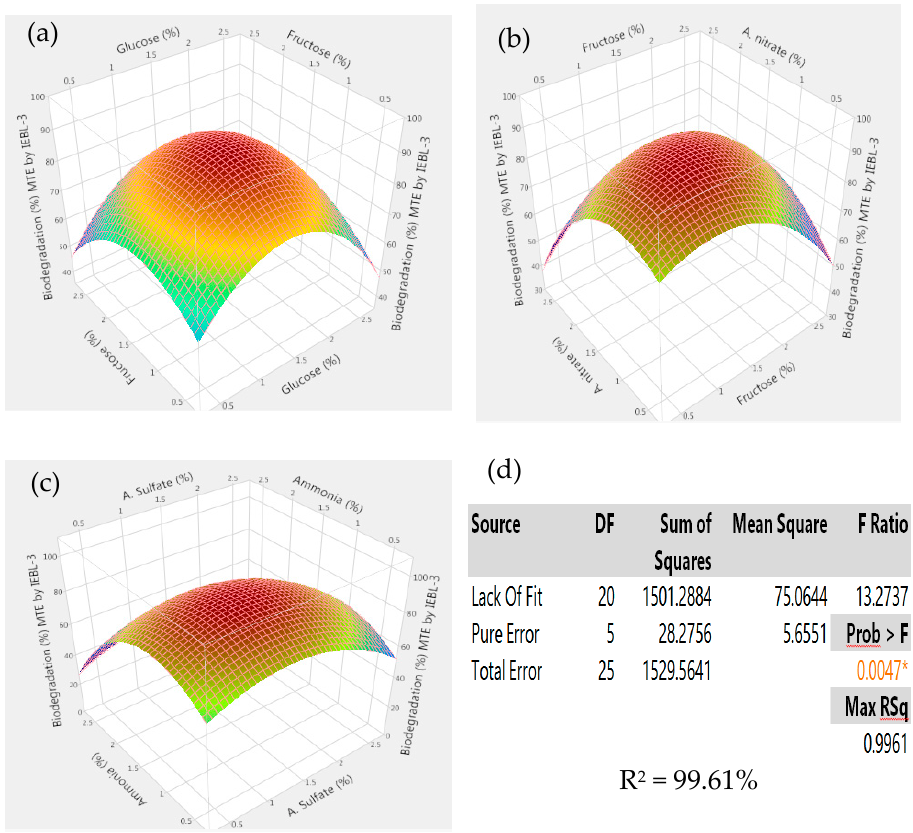
Figure 4. Response surface 3D graphs showing effect of carbon and nitrogen sources on the biodegra- dation of Mujahid Textile (MT) industrial effluent by P. betulinus IEBL-3; graphs represent positive interaction between ( a ) fructose and glucose, ( b ) ammonium nitrate and fructose and ( c ) ammonia and ammonium sulfate. ( d ) Statistical analysis indicating the significant effect of parameters (* indicate significance of value).